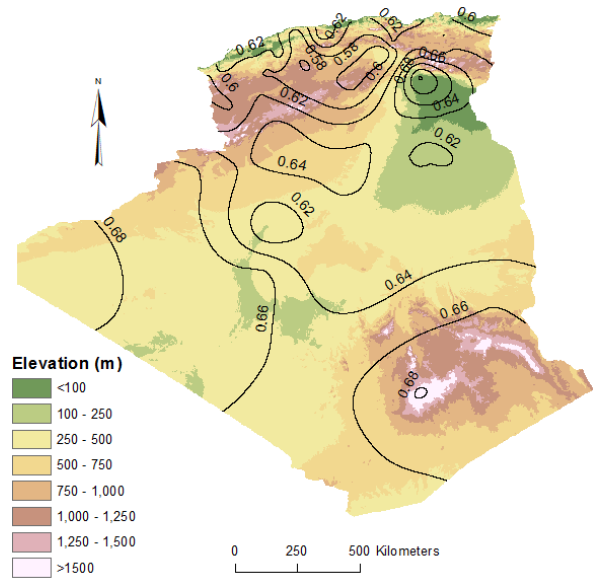
Figure 5. Spatial distribution of CI values in Algeria.